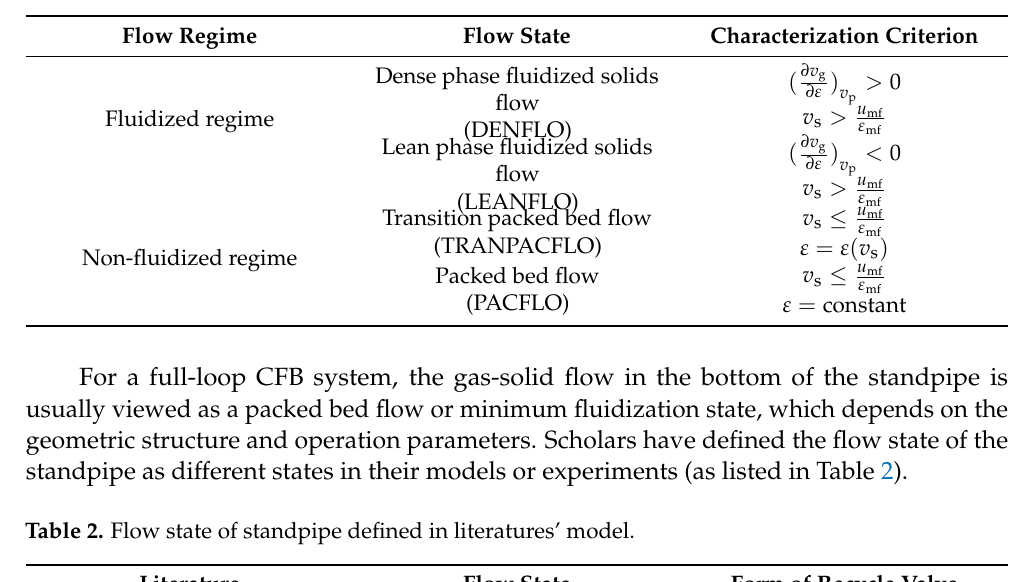
Table 1. Characterization of gas-solid flow state in standpipe.